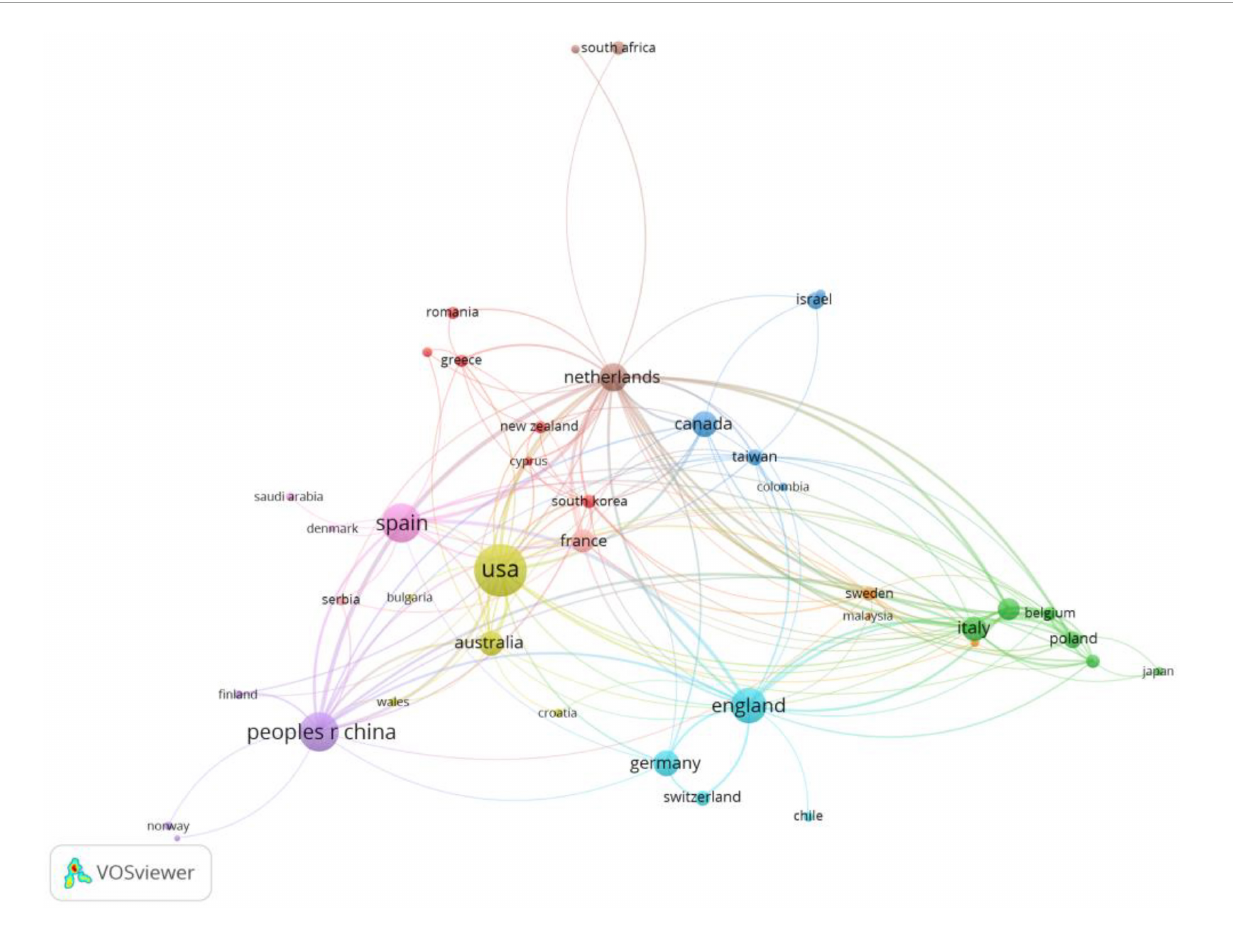
FIGURE3 Countries or regions that show collaboration by citation in multimodal metaphor research (min number of citations of a country/region = 1; visualization by weight of documents).